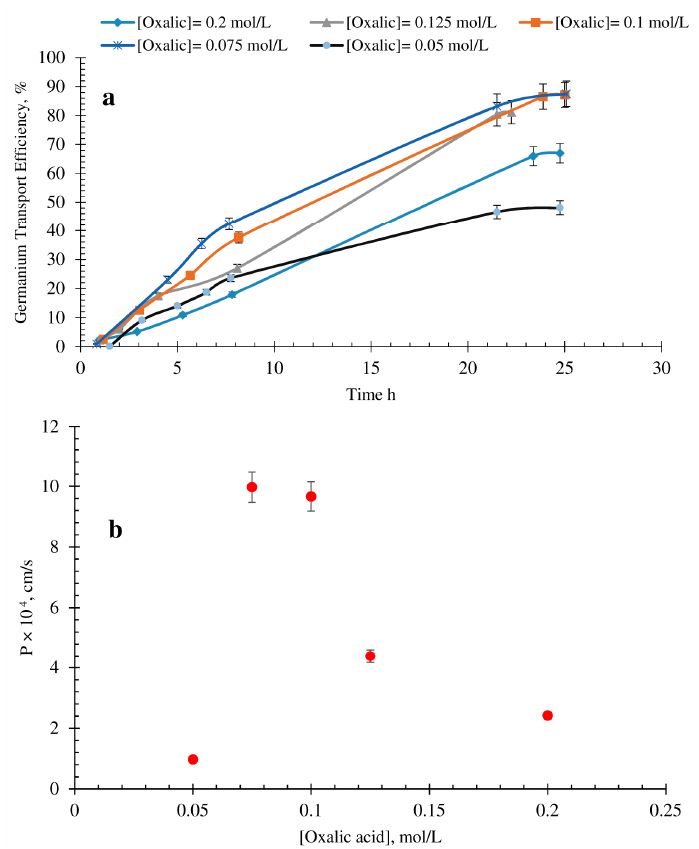
Figure 2. The effect of oxalic acid concentration on ( a ) transport and ( b ) permeability coefficient of germanium on the FSSLM system ([Cyanex 923] = 20% v/v, temperature of 22 °C, and [NaOH] = 0.1 mol/L).